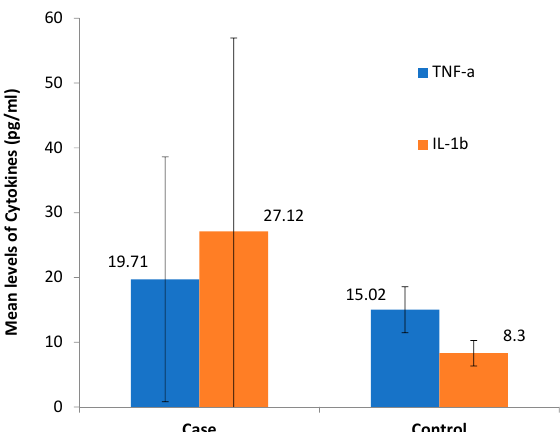
Figure 2. Comparison of tumour necrosis factor alpha (TNF α ) (pg/mL) and interleukin 1 beta (IL-1 β ) (pg/mL) levels in COPD cases and controls. The difference in the IL-1 β levels between cases and controls was significant ( p value 0.0000) and the difference in the TNF- α levels was not significant ( p value: 0.92).